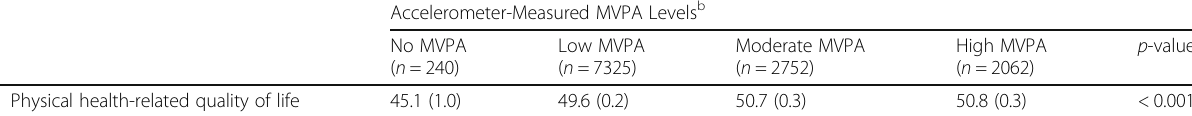
Table 1 Age-adjusted characteristics for Hispanic/Latino adults by accelerometer-measured MVPA levels: HCHS/SOL (Continued)